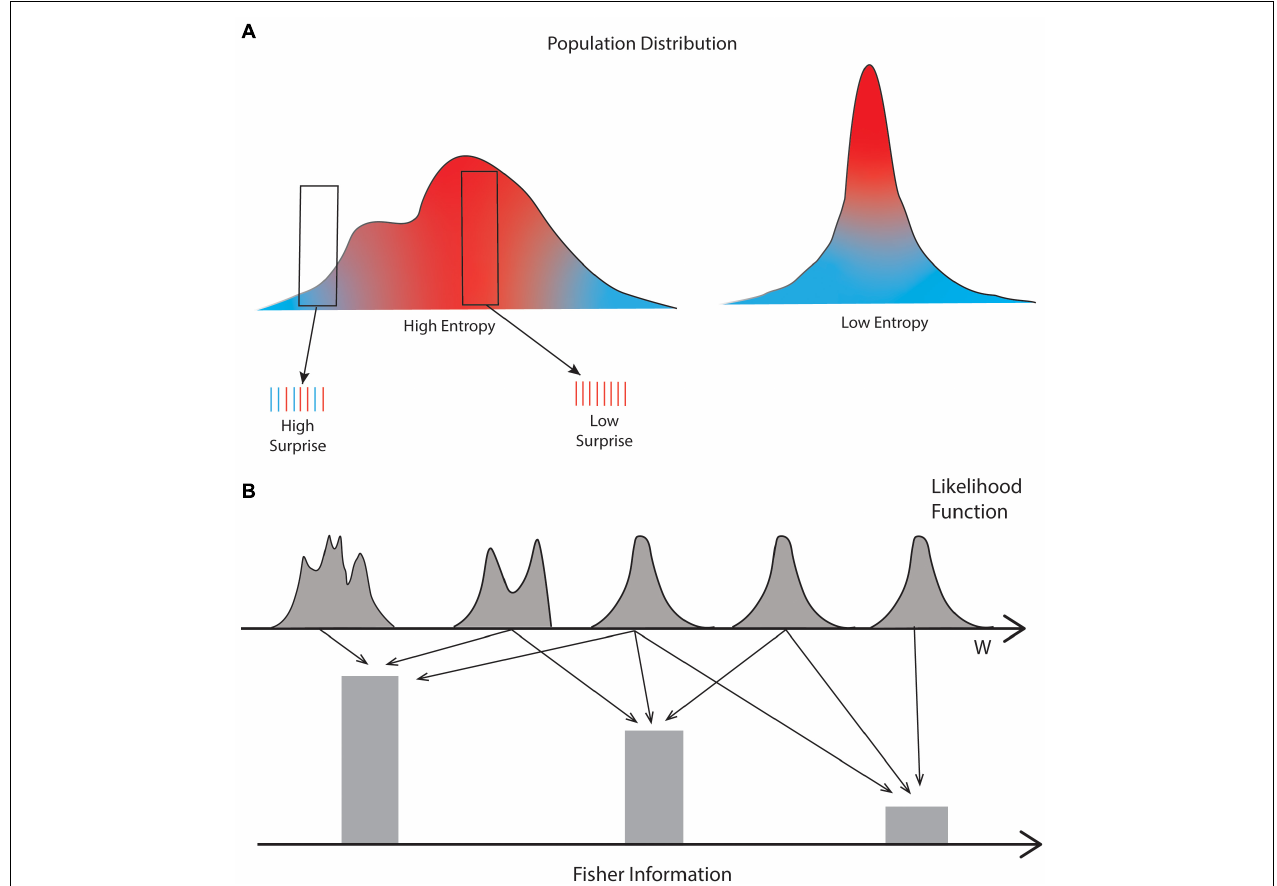
FIGURE 2 | Illustration of the differences between Shannon entropy, amount of surprise, and Fisher information. (A) Shannon entropy captures the spread of the statistics of the population (red and blue curves), such that with more spread, we have more Entropy. In turn, amount of surprise captures how unusual a sample is. For example, the left sample in the figure has elements that are relatively common (red vertical lines) and highly unusual (blue lines), that is, in the fringe of the distribution. By contrast, the right sample only has common elements. Therefore, the left and right samples have high and low amount of surprise, respectively. (B) Fisher Information captures how much information the likelihood function has about its parameter (w). For range of parameters causing great changes of the likelihood function, the Fisher Information is high. The opposite occurs for a range of parameters where the likelihood function is relatively constant. Consequently, while Shannon entropy and Amount of Surprise capture properties of the sensory inputs, Fisher Information captures properties of parameters of cognitive models in the brain.